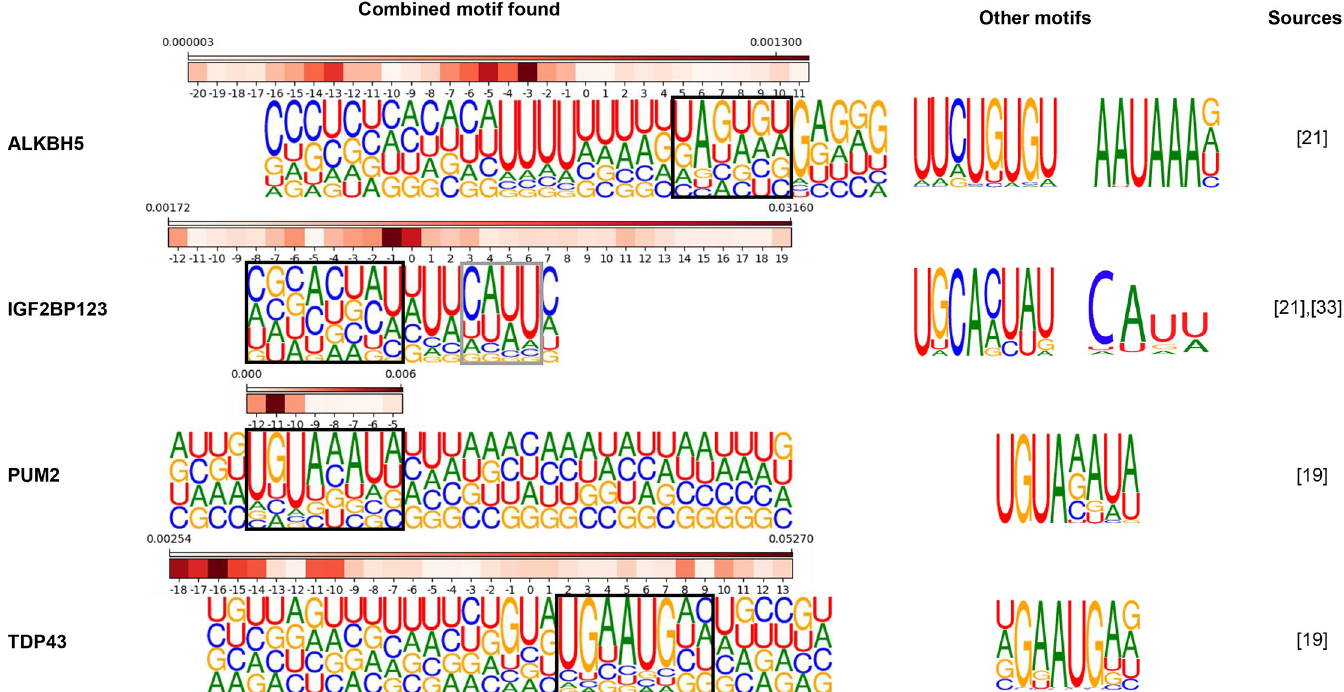
Fig 7. Combined motif analysis of other RBP families. Full-sized sequence motif enriched by response enrichments were aligned with structure motifs. Sequence motifs found by other researches were indicated in separate column for comparison and matching sequence motifs were indicated with black or grey boxes.